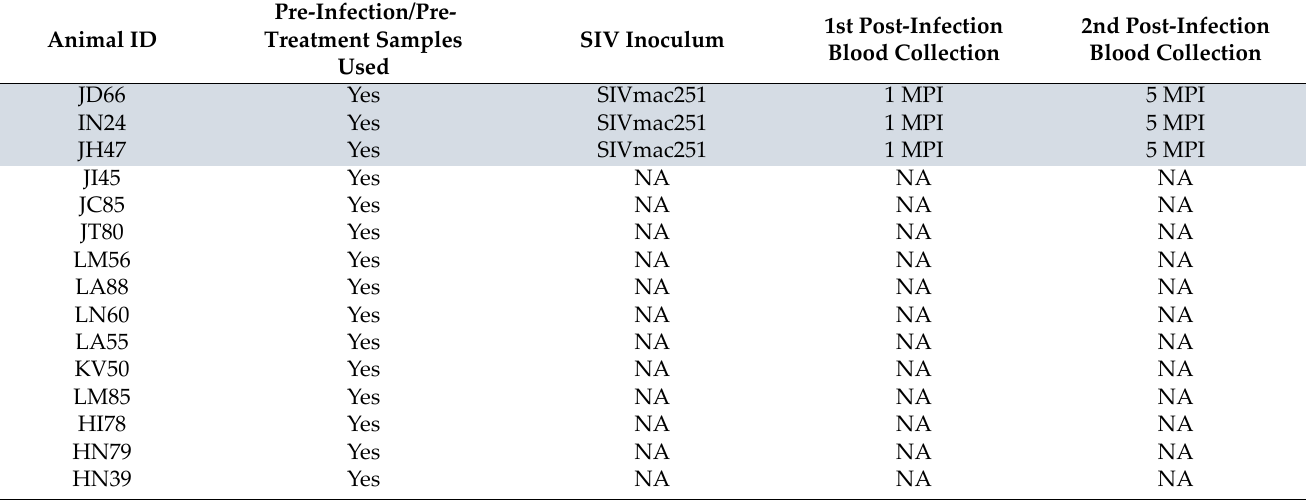
Table 1. Animal IDs, pre‑infection blood collection, SIV inoculum, duration of infection, ∆ 9 ‑THC administration, and ART